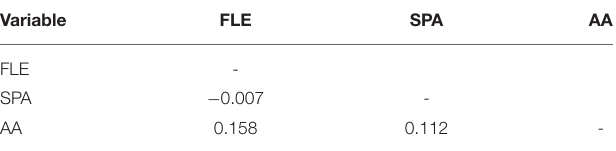
TABLE 5 | Correlations among FLE, SPA, and AA ( N = 90).